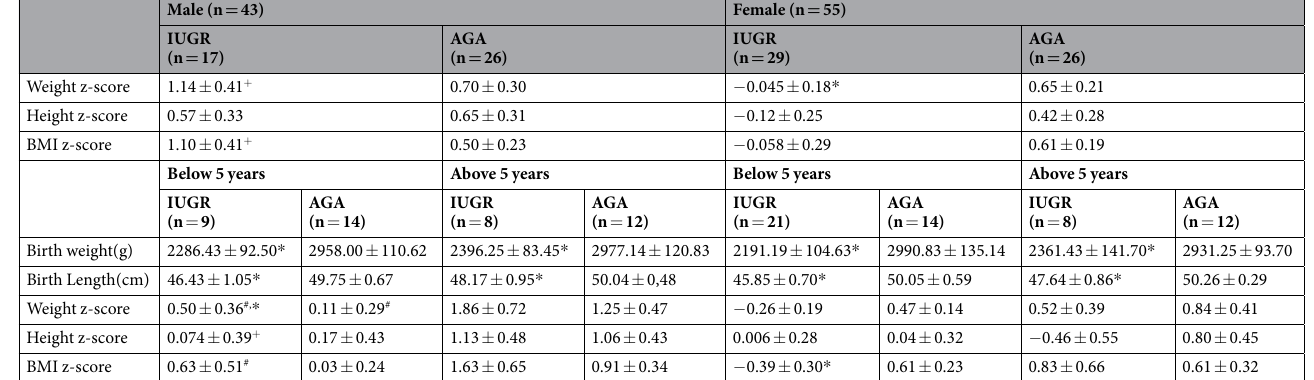
Table 3. Comparison of anthropometric parameters between children born IUGR and AGA at birth (birth weight and length) and at the observation time (weight z-score, height z-score, BMI z-score) expressed as mean ± S.E. Statistical comparisons were performed with multiple factors ANOVA. * denotes statistically significant difference from the respective AGA group. # denotes statistically significant difference from the respective group aged > 5 years old. + denotes statistically significant difference from the respective female